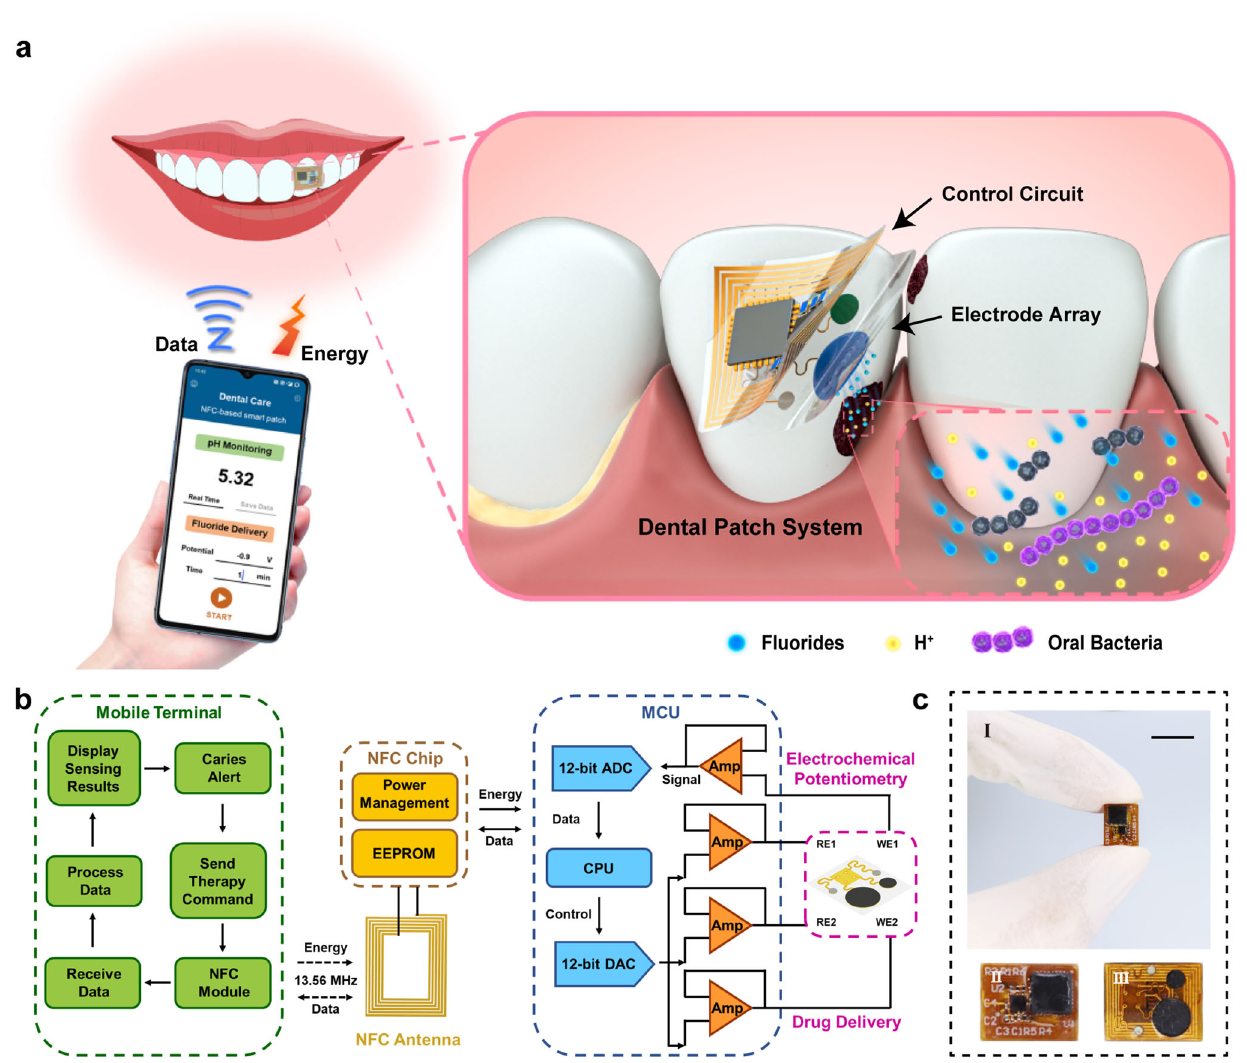
Fig. 1 The wearable theranostic dental patch system. a Schematic of the dental patch system consisting of the control circuit and the electrode array for in situ oral microenvironment monitoring and on-demand drug delivery. b Block diagram and working principle of the system. NFC near fi eld communication, MCU microcontroller unit, ADC analog-to-digital converter, DAC digital-to-analog converter, CPU central processing unit, Amp operational ampli fi er, WE working electrode, RE reference electrode. c Optical image (I) of the dental patch. Scale bar, 1 cm. The front (II) was the control circuit, while the back (III) was the electrode